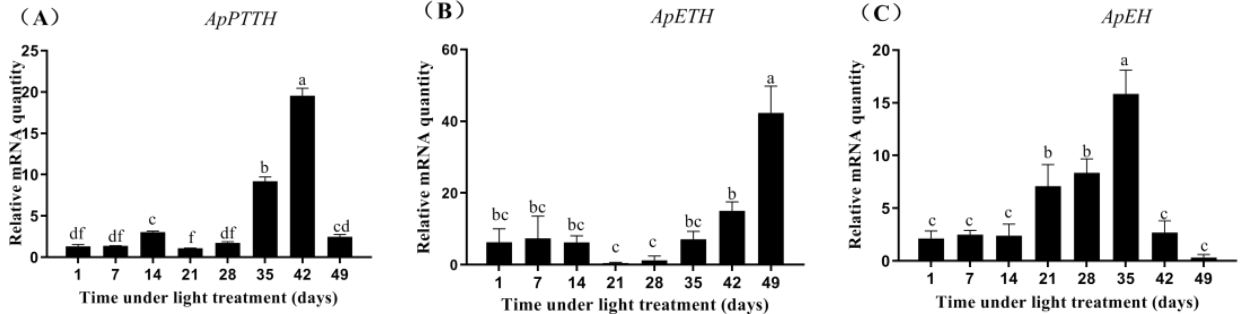
Figure 6. Relative expression levels of ApPTTH in the brain ( A ), ApETH in the tracheae ( B ), and ApEH in the brain ( C ) of Antheraea pernyi pupae during diapause termination and development detected by qPCR. Pupae were exposed to a long photoperiod (17 h L:7 h D) and sampled every 7 days. This experiment was conducted in three replicates; the bar represents mean ± SE (n = 3) and different letters above the bars show significant differences determined using Duncan’s multiple range test ( p < 0.05).